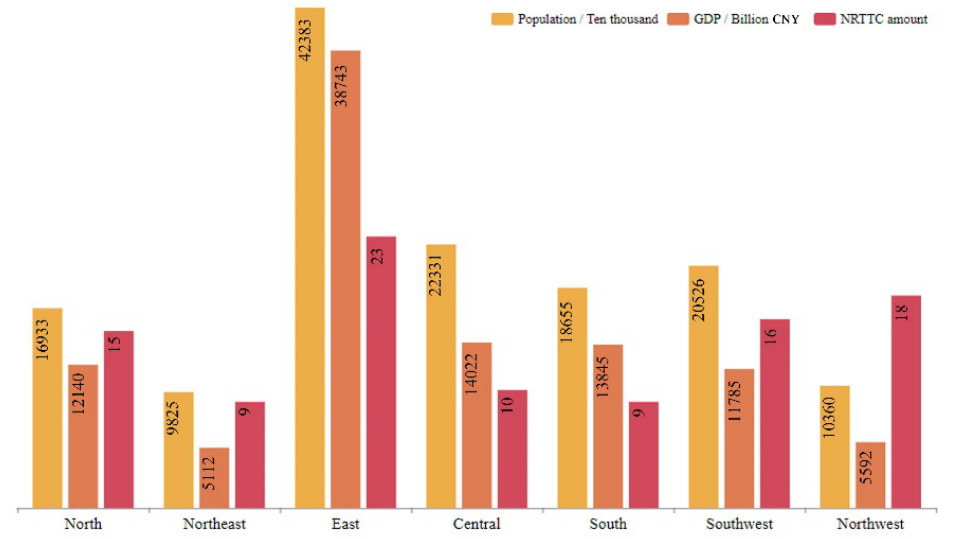
Figure 8. Distribution of the NRTTC in the seven geographical divisions with population and GDP. The total gross domestic product in 2020 (GDP, in billion CNY) from highest to lowest was ranked as follows: east (38,743), central (14,022), south (13,845), north (12,140), southwest (11,785), northwest (5592), and northeast (5112) [67]. The eastern region’s GDP (unit: CNY) is always the highest. The density of the rural tourist towns in the eastern area is relatively large. The radiation range is the widest for the whole country, followed by the central and southern regions and the northern regions. From this, it can be concluded that population and economic development are related to rural